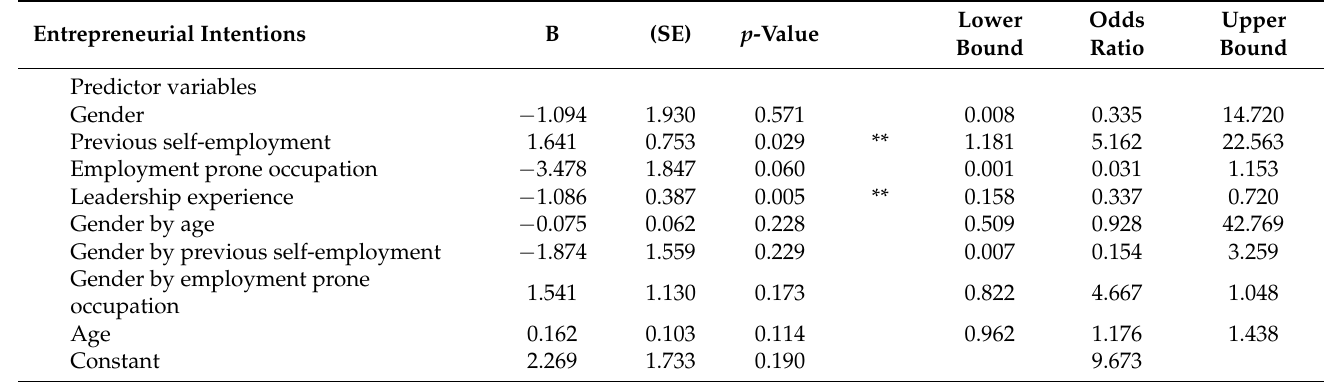
Table 2. Parameter estimates of the binary logistic regression model 1